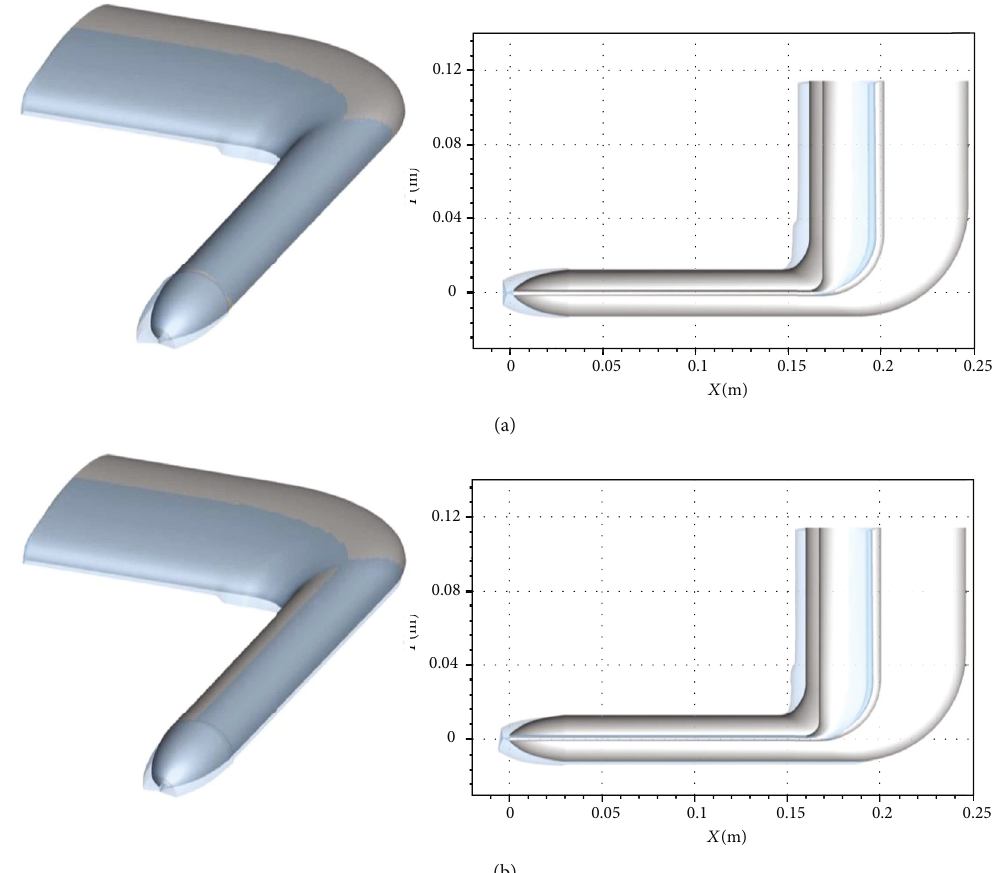
Figure 14: Blocked ice accretion on the pitot-static tube under the rime ice condition at 241 K and di ff erent AoAs: (a) AoA = 0 ° at a blocking time of 180 s (Case 1); (b) AoA = 10 ° at a blocking time of 93s (Case